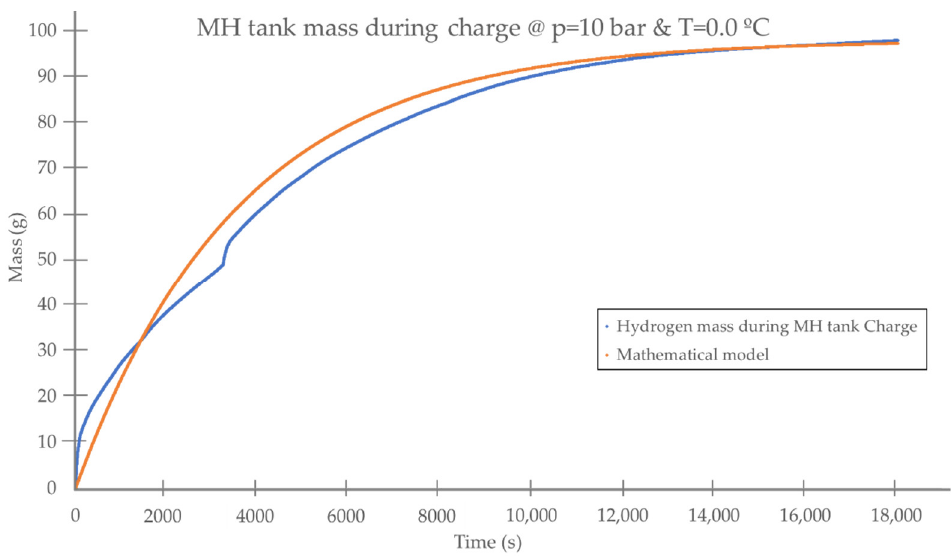
Figure 11. MH tank charging process. Hydrogen mass evolution.